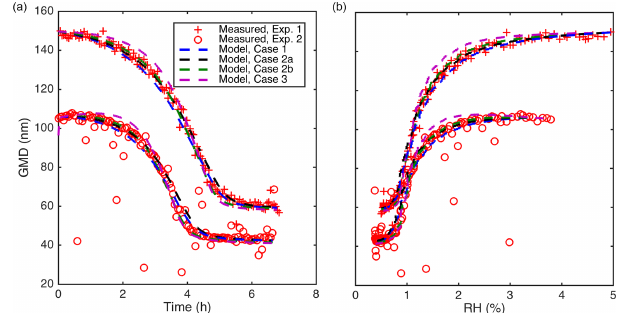
Figure 4. Measured and modelled GMD evolution as a func- tion of (a) time and (b) RH for experiments 1 and 2 performed at T = 288.8K. The modelled particles are composed of S(VI), H 2 O and NH 3 as a particle-phase contaminant. The simulations correspond to Case 1 with H 2 SO 4 being the only evaporat- = 2.00 × 10 9 molkg − 1 ; Case 2a with ing S(VI) species, K H Figure 3. Particle shrinkage at low RH. Measured (a) and 2 SO 4 = H 2 SO 4 being the dominating evaporating S(VI) species, K H modelled (b) particle number size distribution evolution dur- 2 SO 4 ing experiment 2 performed at T = 288.8K for Case 2a, with = H 2 SO 4 being the dominating evaporating S(VI) species, K H 2 SO 4 = 1.43 × 10 10 . Panels (c) and (d) 2.40 × 10 9 molkg − 1 and x K SO 3 show the modelled particle water mole fraction, χ H and N:S, 2 O respectively. Table S1, simulations 1–4 and 13–16). The pure-liquid saturation vapour pressures of H 2 SO 4 and SO 3 are calculated with Eq. (11), N–K–L parameterisation (Kulmala and Laaksonen, 1990; Noppel et al., 2002), and Eq. (12) (Nickless, 1968),